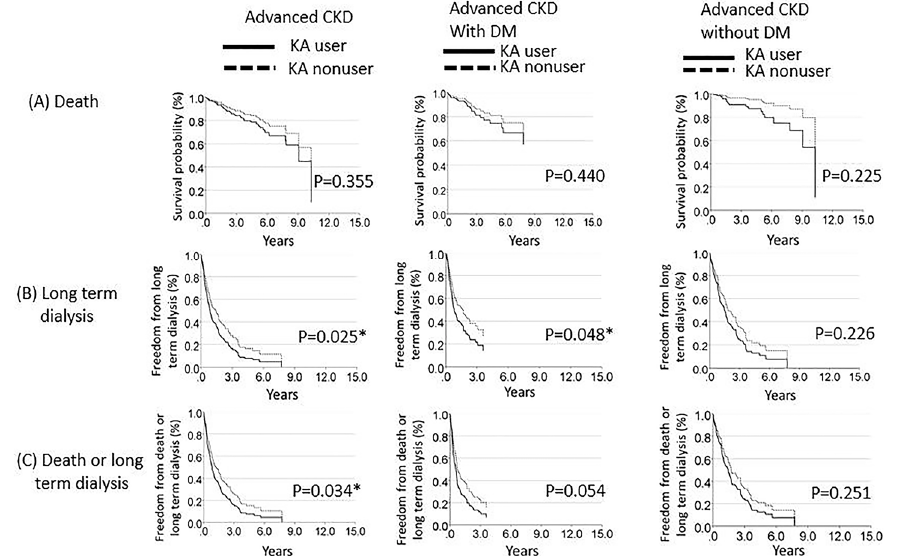
Figure 2. Survival curves, derived from the Cox proportional hazards regression analysis, for ( A ) death, ( B ) long-term dialysis, and ( C ) the combined outcomes defined as death or long-term dialysis, for advanced chronic kidney disease patients who received or did not receive keto / amino acid treatment. CKD, chronic kidney disease; DM, diabetes mellitus; KA, ketoanalogues. * Significant p ( p < 0.05)